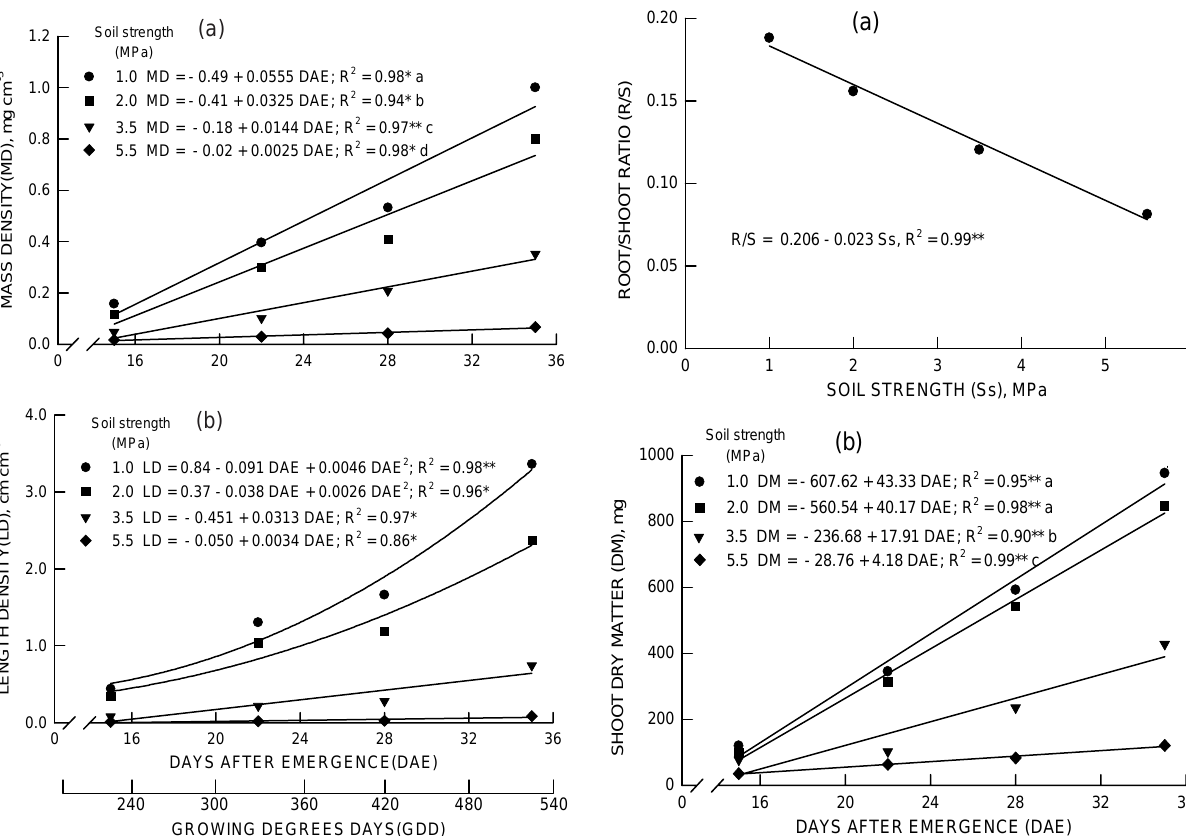
Figure 4. Wheat root/shoot ratio (a) and shoot dry matter (b)under different soil